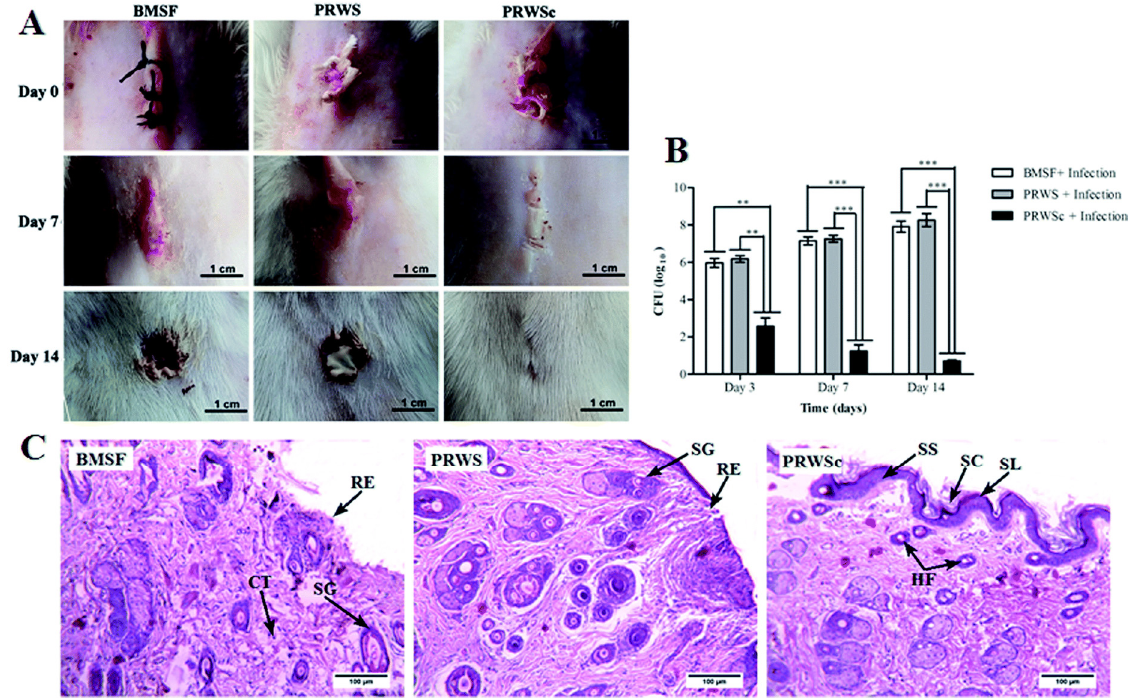
Figure 6. ( A ) S. aureus infected wound of animals sutures on days 0, 7, and 14. ( B ) Colony forming unit (CFU) count data of the S. aureus infected incised wound. (C) Histopathological changes of the skin tissue of animals sutured with BMSF, PRWS, and PRWSc after 14 days. (Reprinted with per- mission from Ref. [59]. Copyright 2017 Royal Society of